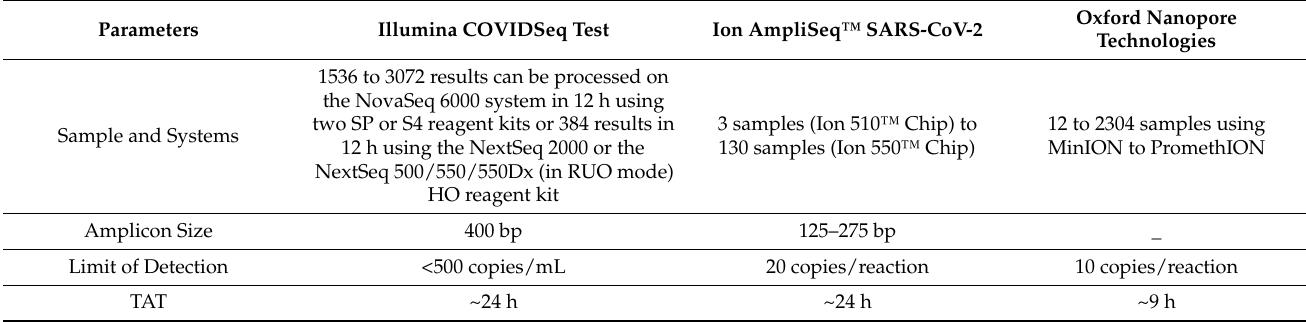
Table 1. Comparison of selected Illumina, Ion torrent, Nanopore WGS assay for detection of COVID-19 as claimed by respective